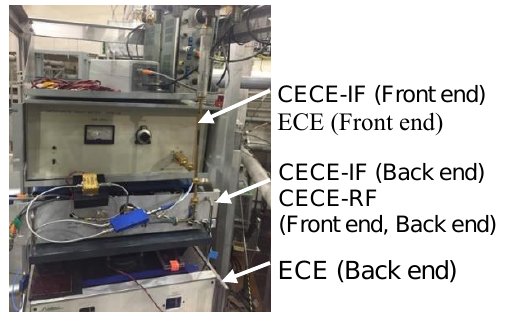
Fig. 3. Photo of CECE radiometer system in Heliotron J .